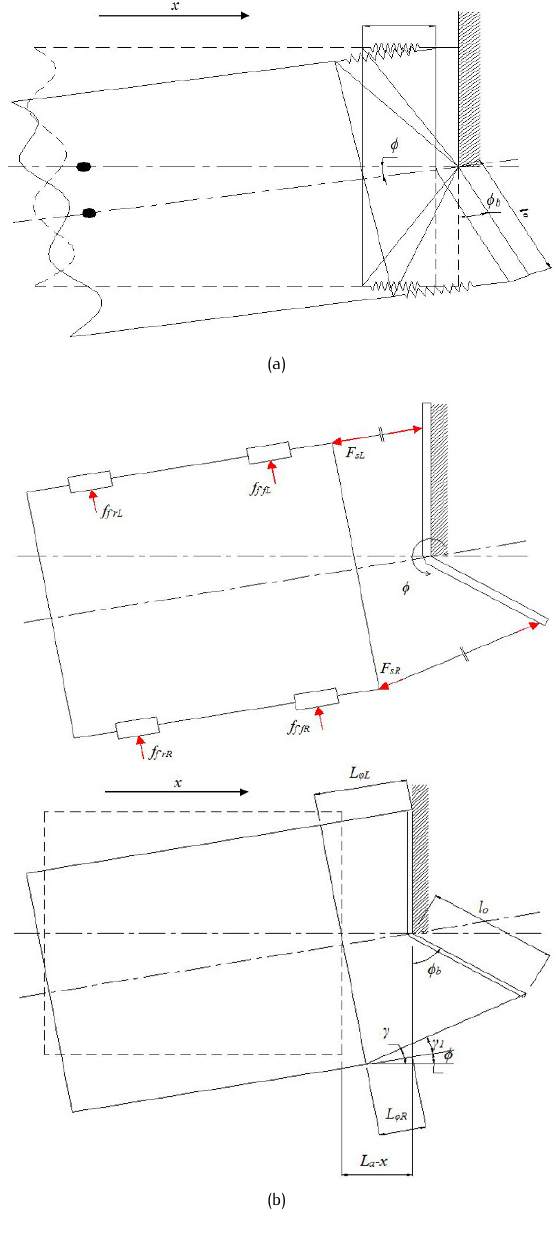
Figure 4. (a) illustration drawing of the front-end deformation due to vehicle yawing (--- before yawing, — after yawing); (b) sim- plification of Figure 4(a) and its free-body